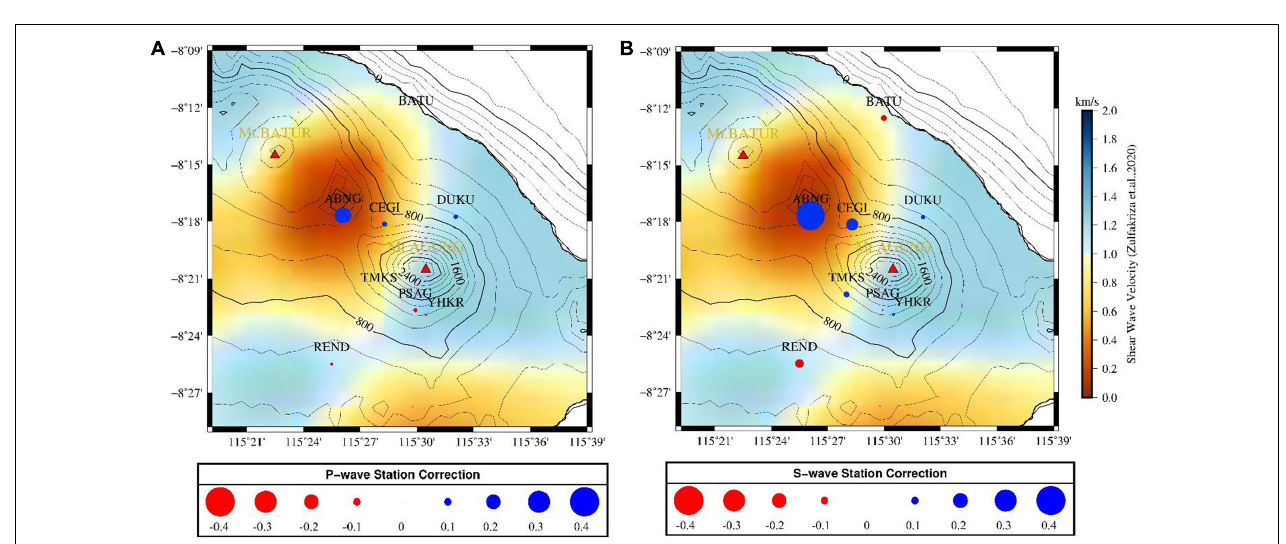
FIGURE 9 | Distributions of (A) P-wave and (B) S-wave corrections at each station calculated using joint velocity-hypocenter determination technique. The station correction at each seismographic station is plotted with filled circles. The absolute magnitude of station corrections is represented by its size; whereas, the sign is denoted by its color; i.e., red and blue indicate negative and positive values,